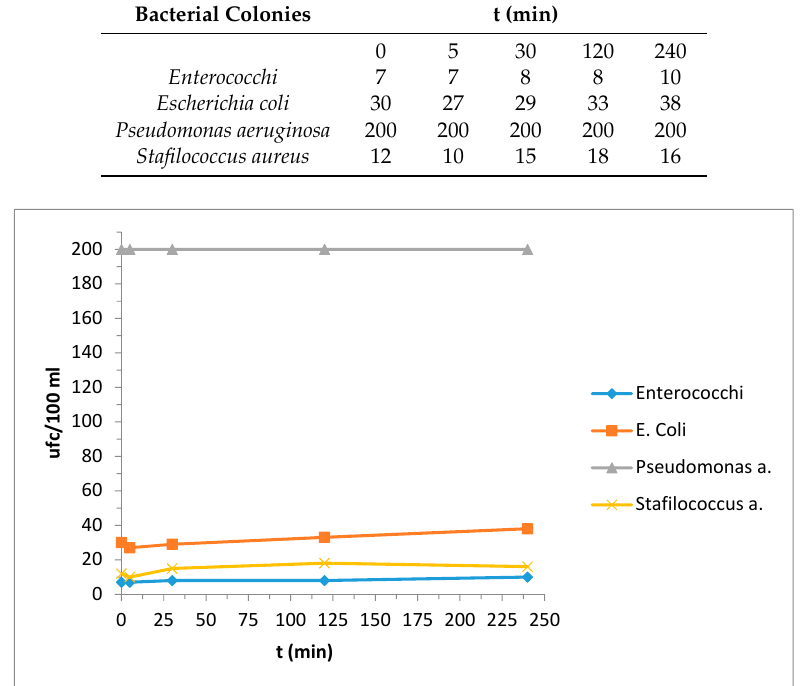
Figure 5. Evaluation of the concentration of the bacterial strains as a function of time.